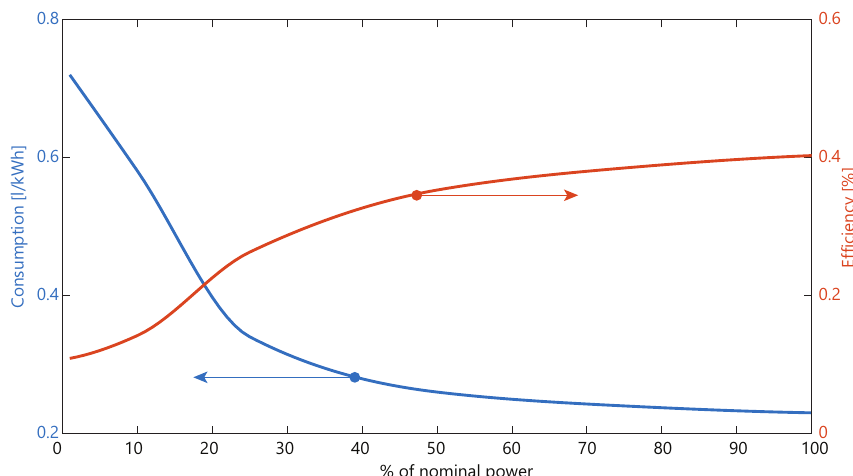
Figure 8. Trend of efficiency (red) and average consumption (blue) as the ratio of the delivered power to the nominal power varies. Table 4. Average values of efficiency and consumption of generators. P